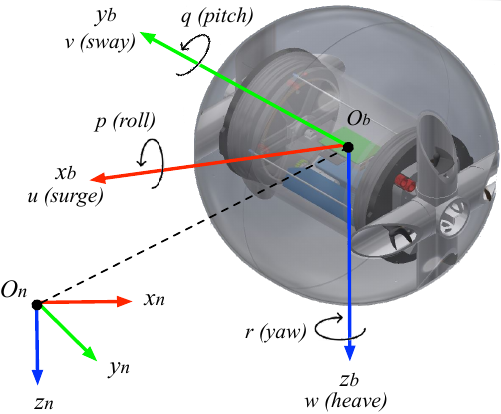
Figure 6. Schematics of the developed underwater vehicle with the frames of reference used in the equations of